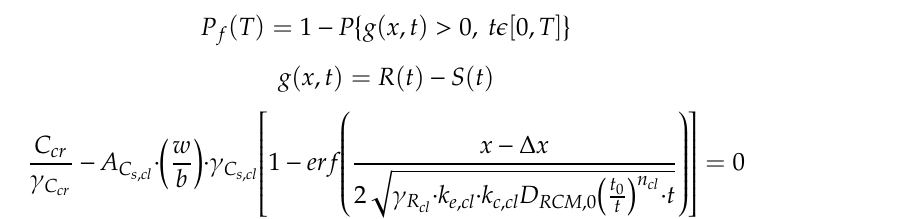
Figure 12. Probability of failure and target service life.